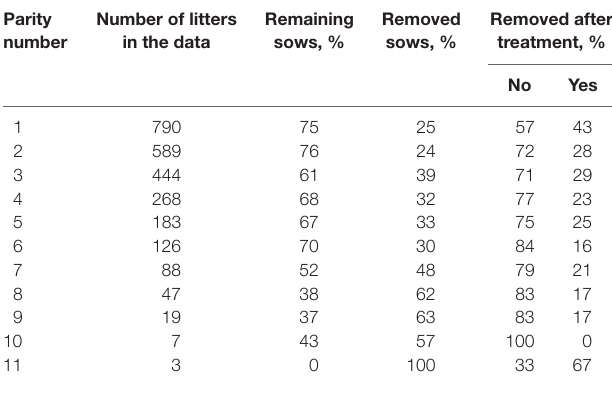
Table 2 | Shares of removed and remaining sows in a research farm herd, by parity, and shares of removed sows by veterinary treatment. Parity number of litters number in the